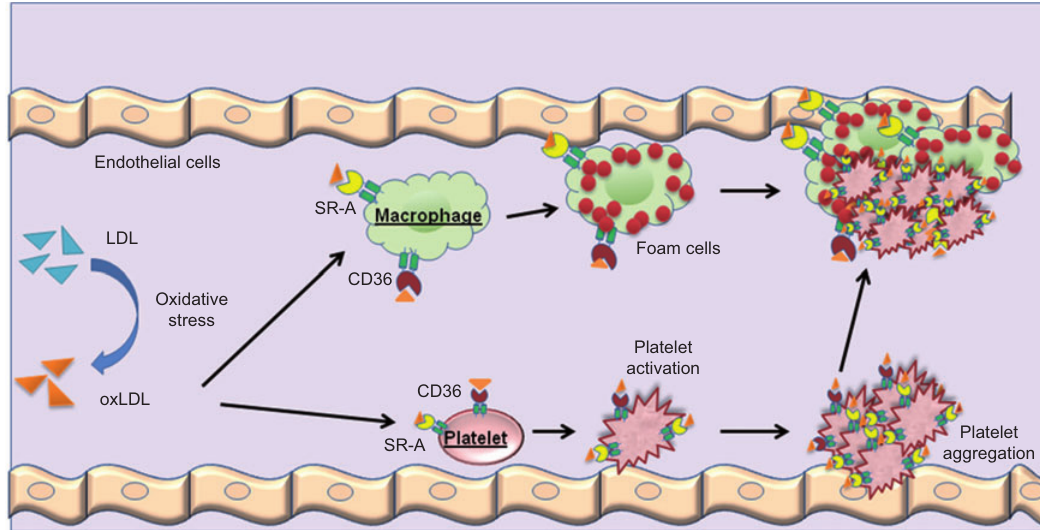
Figure 2 SRs and their role in